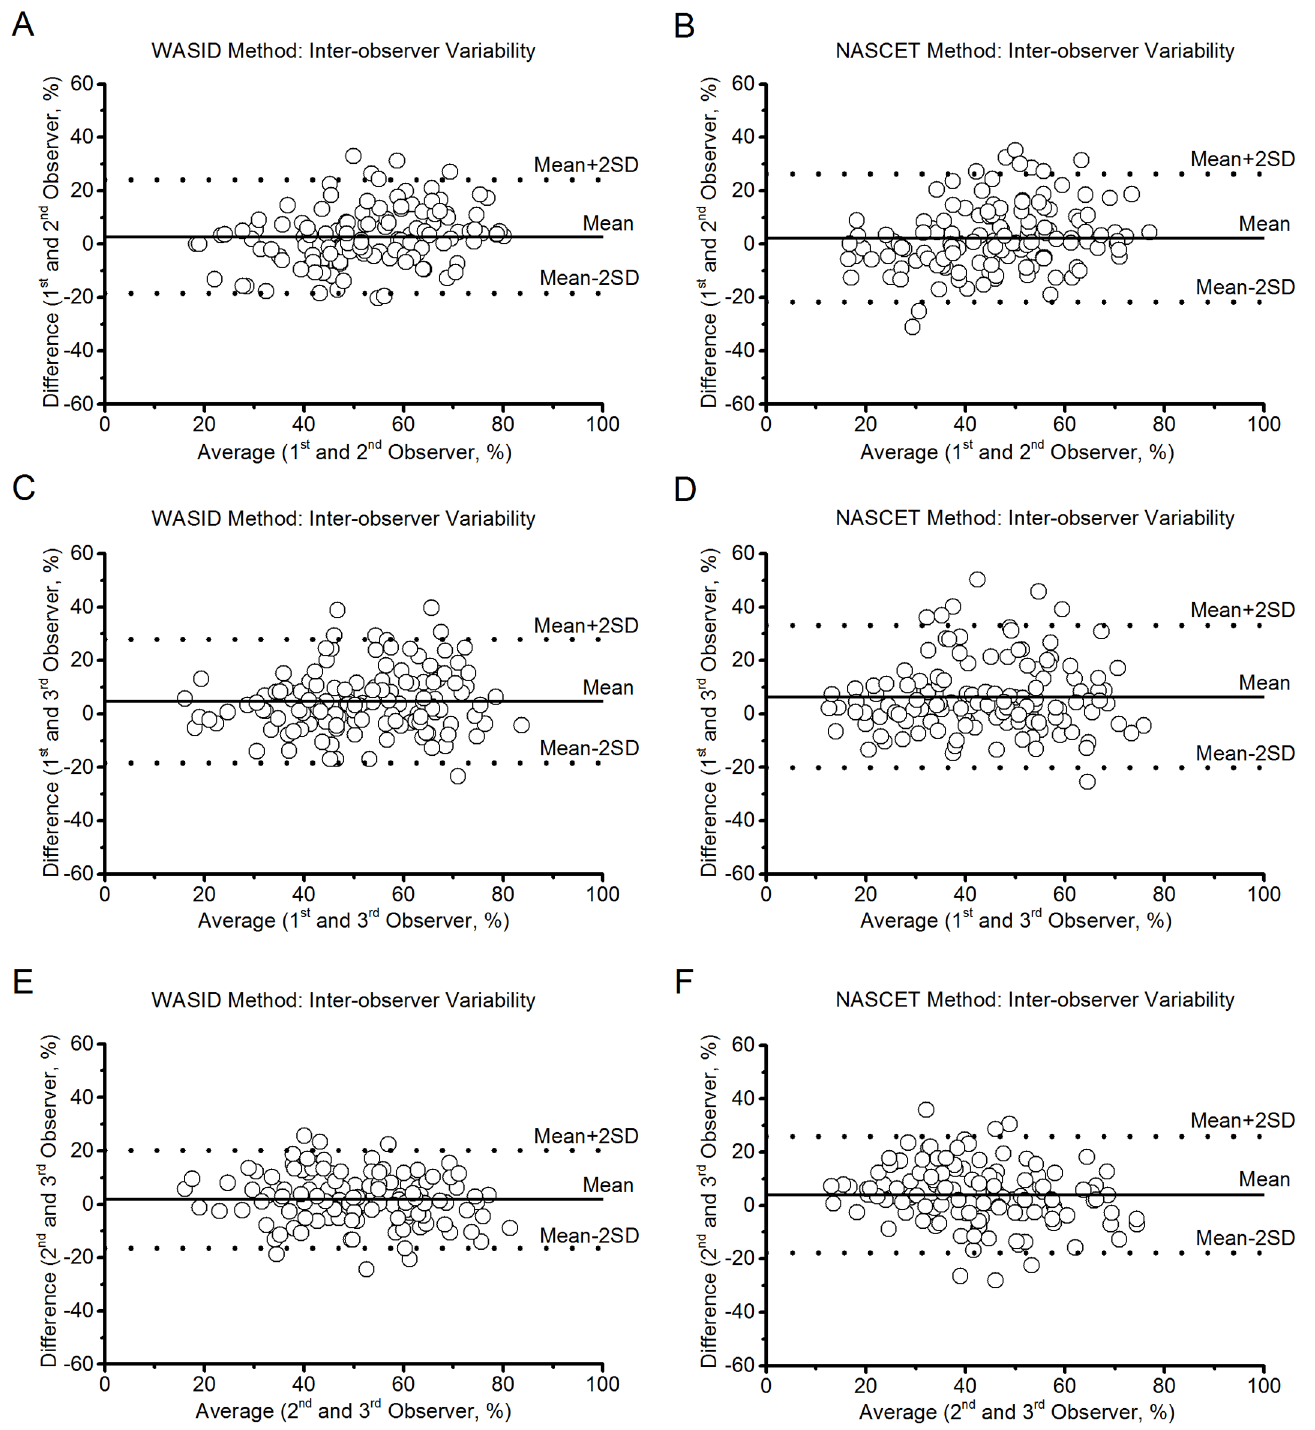
Fig 4. Bland-Altman plots of inter-observer reproducibility of the NASCET and WASID methods. (A, C and E) WASID method for Observers 1&2, 1&3 and 2&3, respectively. (B, D and F) NASCET method for Observers 1&2, 1&3 and 2&3, respectively.